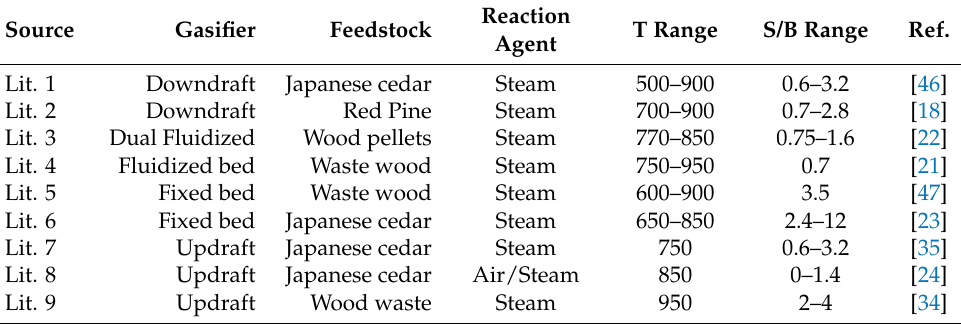
Table 4. Results from the literature used in model